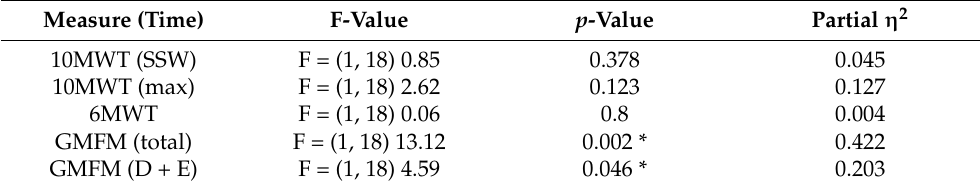
Table 4. Overview of the results of the MANCOVA of and the interaction effects between the groups with the main factor time and the dependent variables (functional